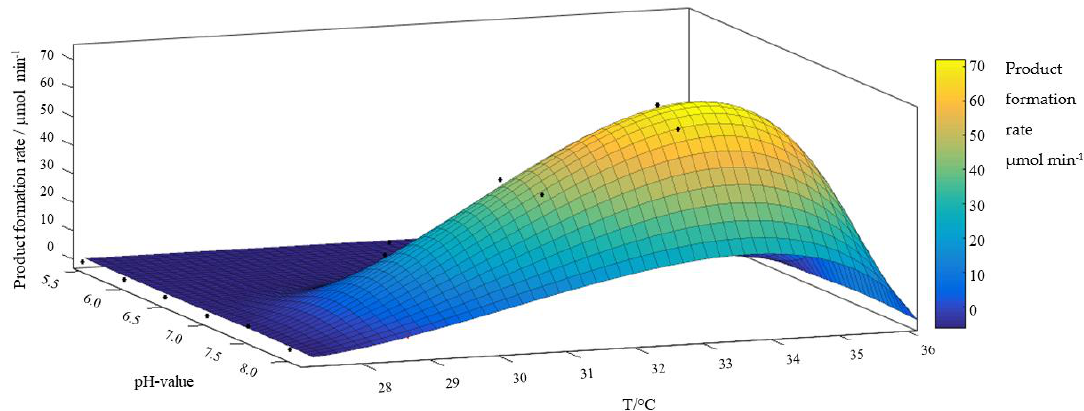
Figure 4. Response surface (view from the perspective over T) for the experimental design over T. An amount of 1.5 M of 1 in a final volume of 500 µ L, 0.1 M of bu ff er (6.0 ≤ pH ≤ 8.5), 7 µ L of DMSO, and 10 mg of freeze-dried E. coli cells hosting DERA, 28 ◦ C ≤ T ≤